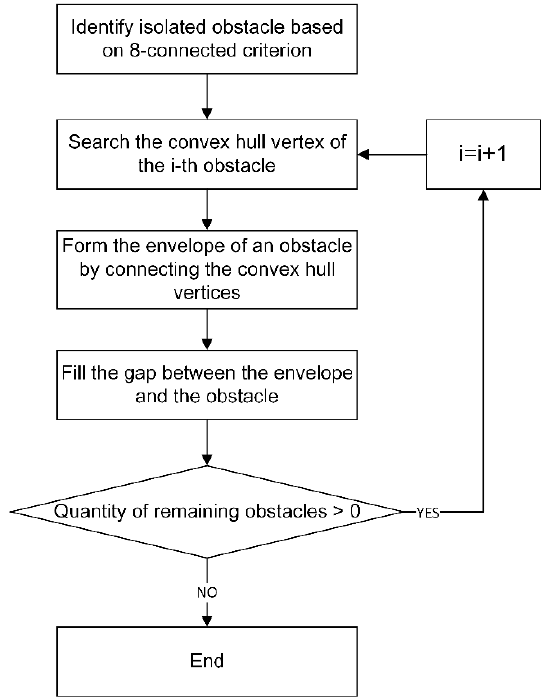
Figure 12. Flow chart of convex hull transform for grid map.